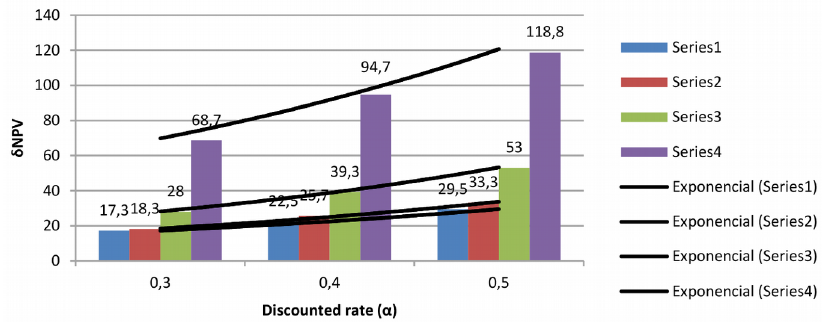
Figure 59. Comparing the effects of alpha rate and number of activities in increasing NPV